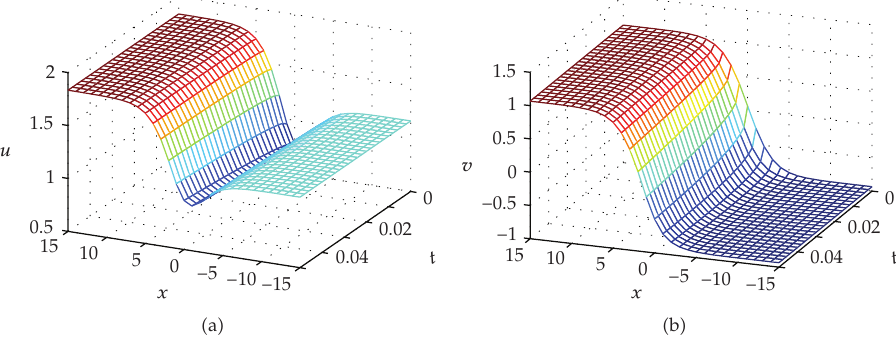
Figure 7: Explicit numerical solutions with h (cid:8) − 1, α (cid:8) 1 / 2, β (cid:8) 2 / 3, λ (cid:8) 0 . 1, b (cid:8) 1, and k (cid:8) 1 / 3.